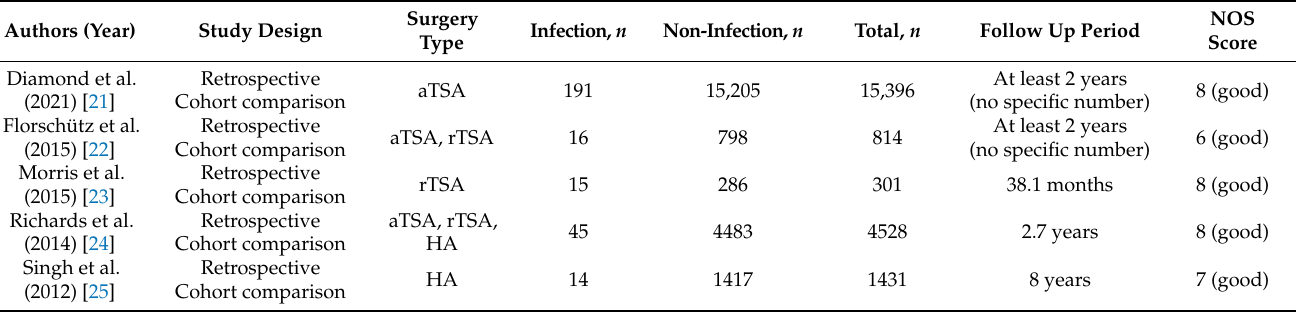
Figure 1. Flow chart for literature identification using Preferred Reporting Items for Systematic Reviews and Meta-Analyses (PRISMA) guidelines. Table 3. Characteristics of the included studies.